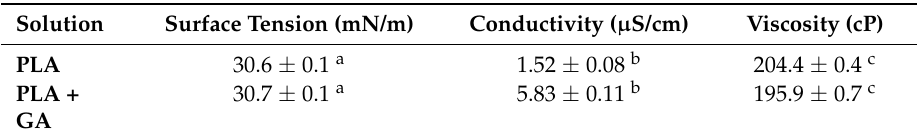
Table 2. Values of surface tension, conductivity, and viscosity of the neat polylactide (PLA) and PLA containing gallic acid (GA)